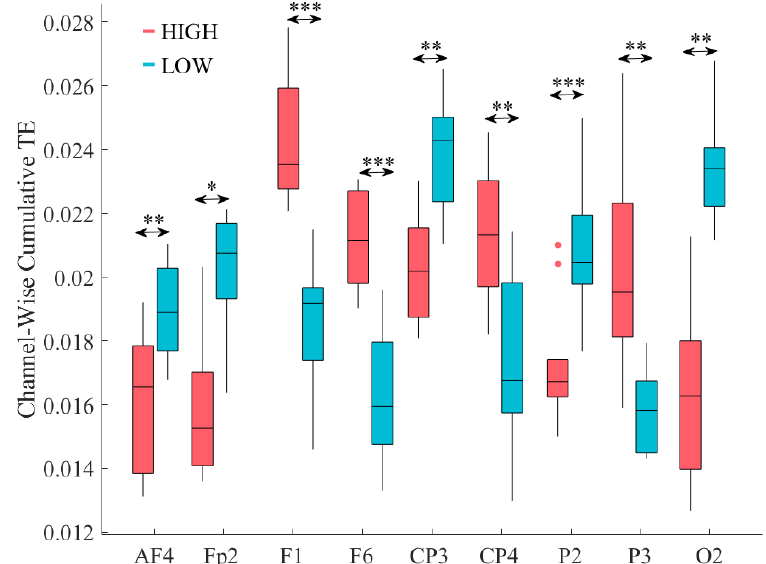
Figure 3. Eyes-Closed (EC) setting. Channel-wise paired Wilcoxon rank sum test between total TEs of participants in HIGH and LOW stress-susceptible groups. There were significant differences between total TEs of nine EEG channels. They were: FP2, AF4, F1, F6, CP3, CP4, P2, P3, and O2. In this figure, the asterisks mark these significant differences (* p < 0.05, ** p < 0.01, *** p <